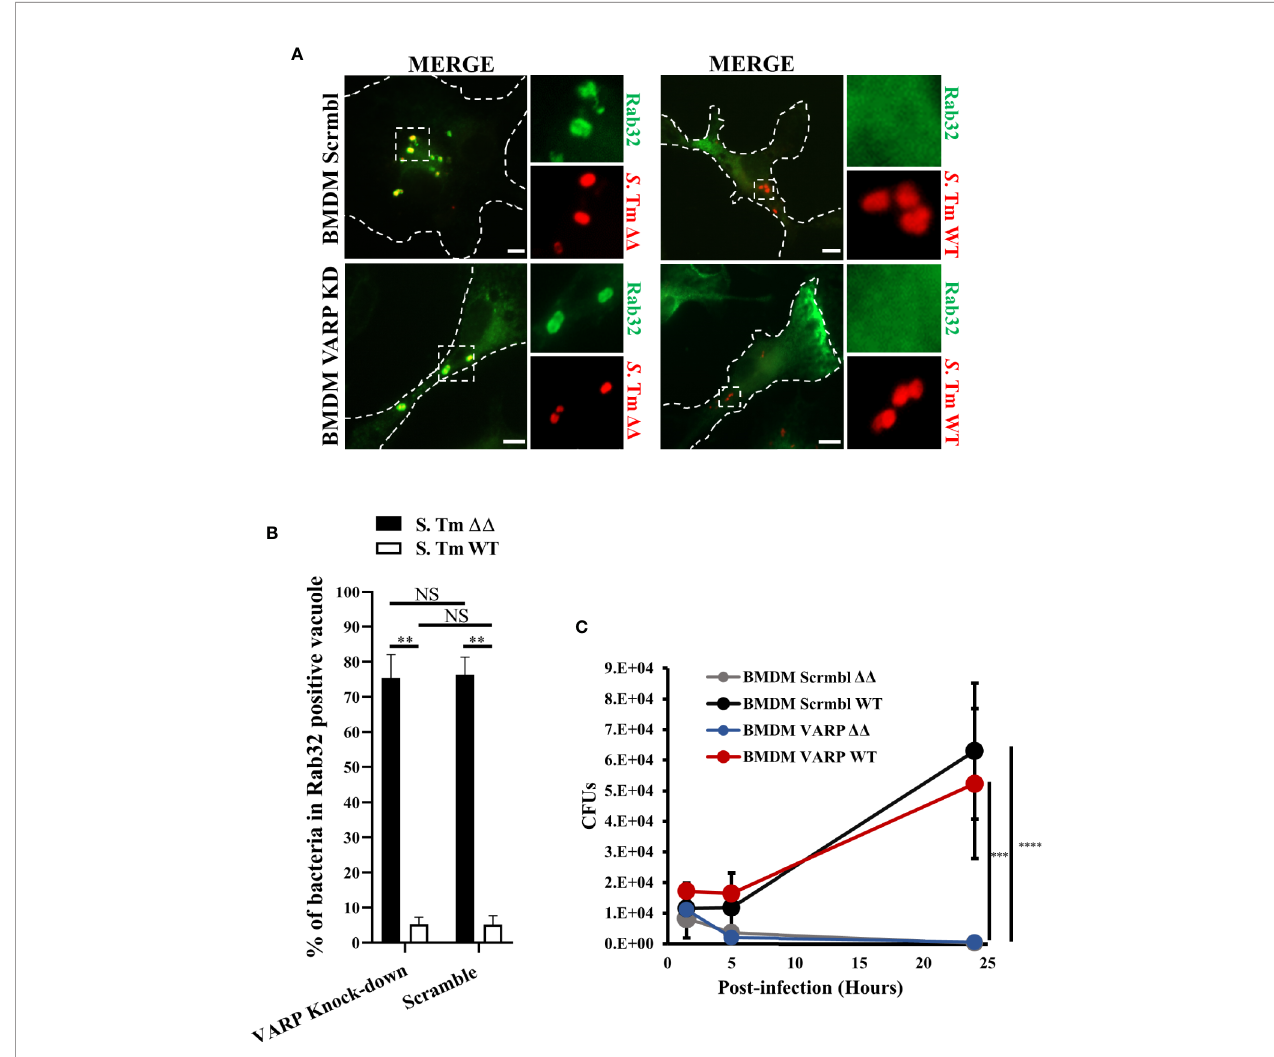
FIGURE 3 | VPS9-ankyrin-repeat-protein (VARP) is not required for Rab32 traf fi cking to Salmonella -containing vacuoles (SCV) and its role in Salmonella killing is dispensable. (A) BMDM cells transduced with control (Scramble) or VARP shRNA (VARP KD) were infected with mCherry S . Typhimurium D gtgE D sopD2 ( DD ) or WT for 2.5 h, fi xed and stained with anti-Rab32 (green). Images were acquired using fl uorescent microscopy. (B) The percentage of S . Typhimurium in Rab32-positive vacuoles were quanti fi ed in scramble and VARP KD cells and the ± standard-deviation of three independent experiments are shown. (C) BMDM cells depleted for VARP were infected with S . Typhimurium DD or WT, lysed at the indicated time points and colony-forming units were calculated. Values are standard-deviation of CFUs at each time points from three independent experiments. S . Tm, Salmonella Typhimurium; KD, Knock-down; CFUs, Colony-forming units; Scale bar: 5 m m. (Student ’ s test; **p < 0.01, ***p < 0.001, ****p < 0.0001, NS, non statistically